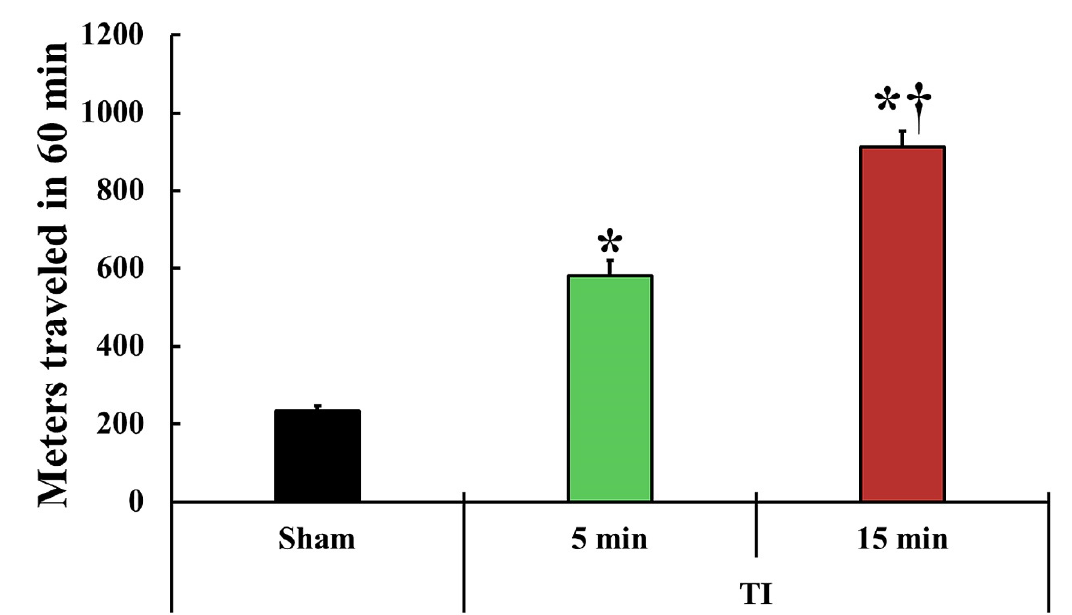
Figure 1. Change in spontaneous motor activity (SAM). SMA is evaluated in the traveled entire distance (meters) in 60 min at one day after tFI ( n = 5 or 7, respectively; * p < 0.05, significantly dif- ferent from the mild and severe sham group, and † p < 0.05, significantly different from the mild tFI group at the corresponding time). The bars indicate the means ± SEM.